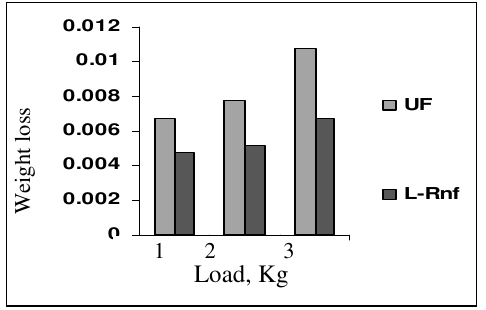
Figure 14. Wear resistance of SF-Rnf composite